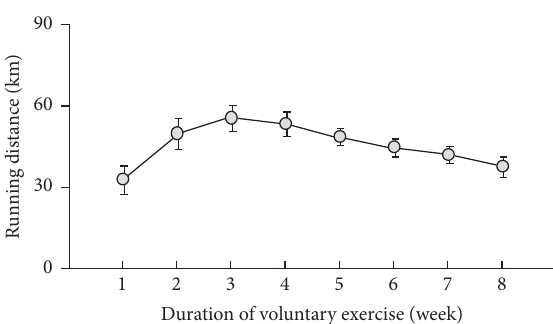
Figure 1: Running distance of the voluntary exercise group mice. Integrated running distance per week during the experimental periods was plotted.